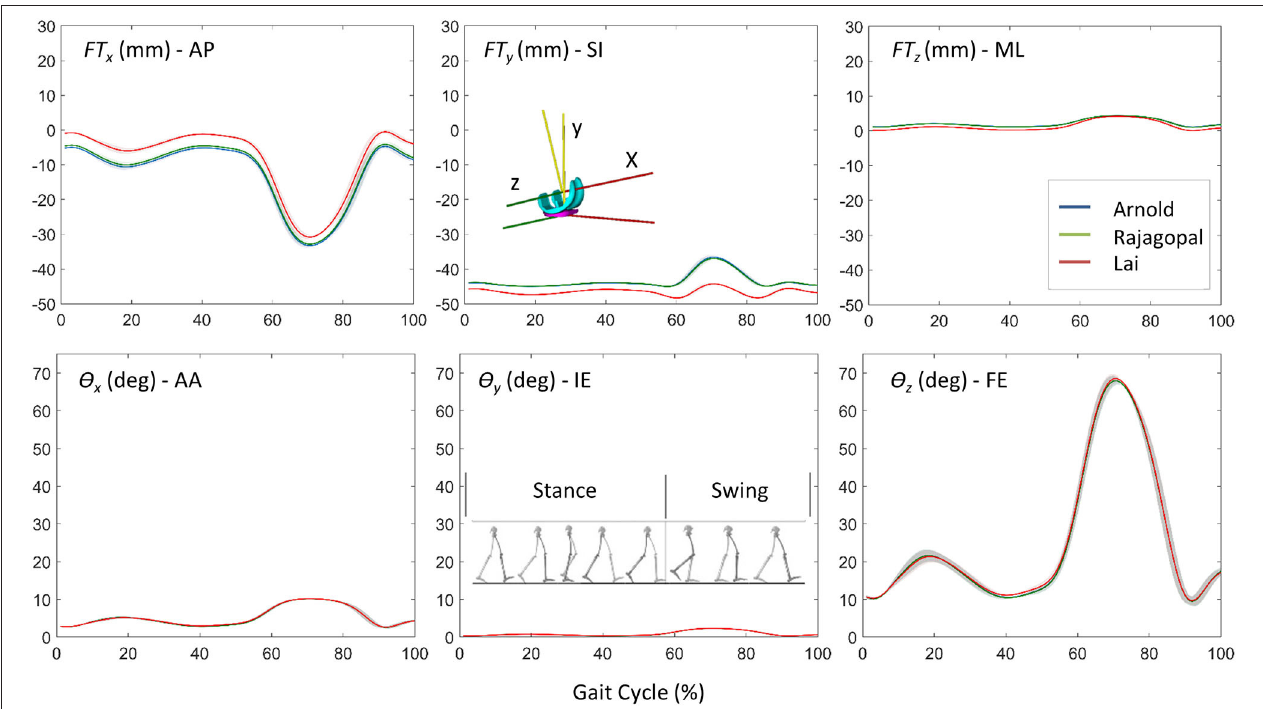
FIGURE 4 | The comparison of kinematic results for the three models: position vector components ( FT x , FT y , and FT z ) and Euler angles ( θ x , θ y , and θ z ) that defined the pose of the TI with respect to the FC during the simulated gait trial.